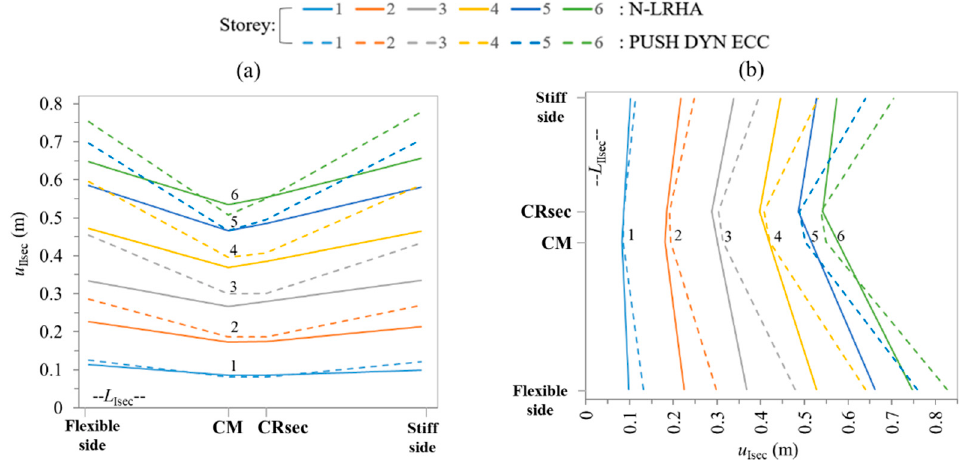
Figure 12. Plan inelastic displacement profiles of case 2 building at NC: ( a ) u IIsec along the II sec axis, ( b ) u Isec along the I sec axis. Proposed pushover procedure vs. N-LRHA.